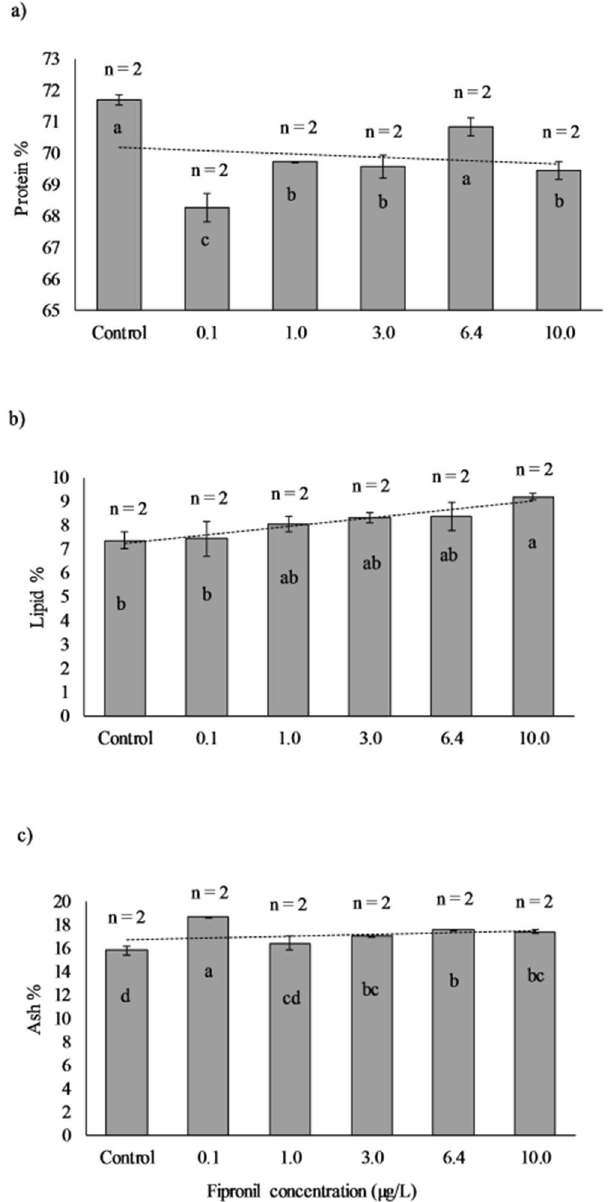
Figure 5. Analysis of body composition of juvenile shrimp under different fipronil concentrations. The horizontal axes in (6.a, 6.b, and 6.c) represent the six fipronil concentrations ( µ g/L) used during the experiment while the vertical axes represent the protein % (in 6.a), lipid % (in 6.b), and ash % (in 6.c) in bodies of juvenile shrimp measured at the end of the experiment. Dashed lines are fitted regression lines. Error bars indicate the standard errors (n = number of samples analyzed from each treatment). One-way Analysis of Variance (P < 0.05) showed that means in columns not sharing the same letter are significantly